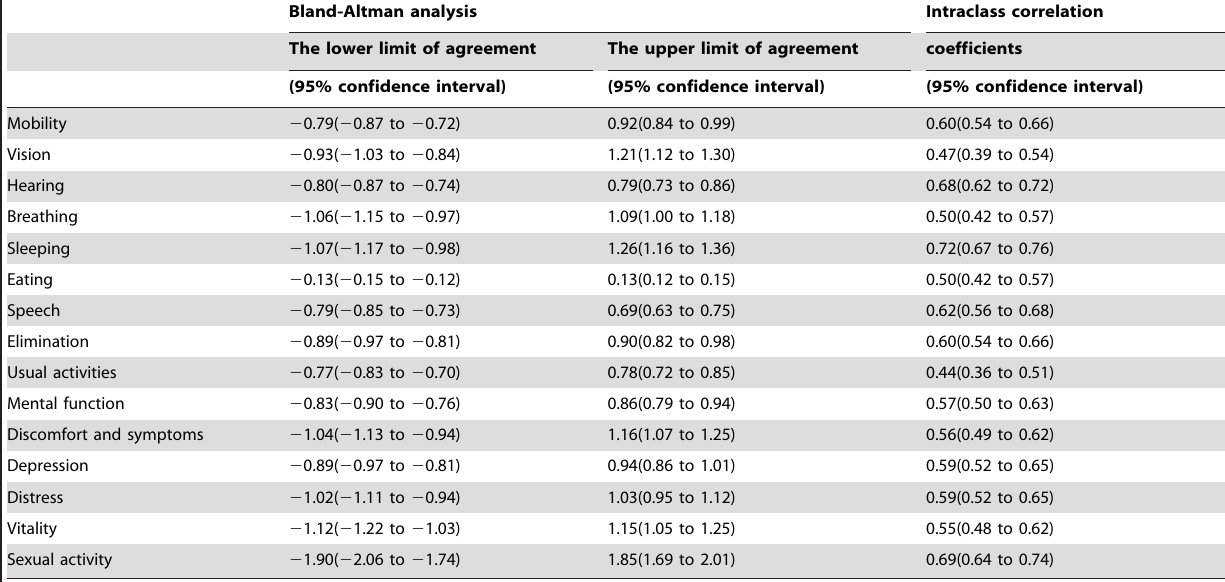
Table 3. Repeatability of items on the 15D.